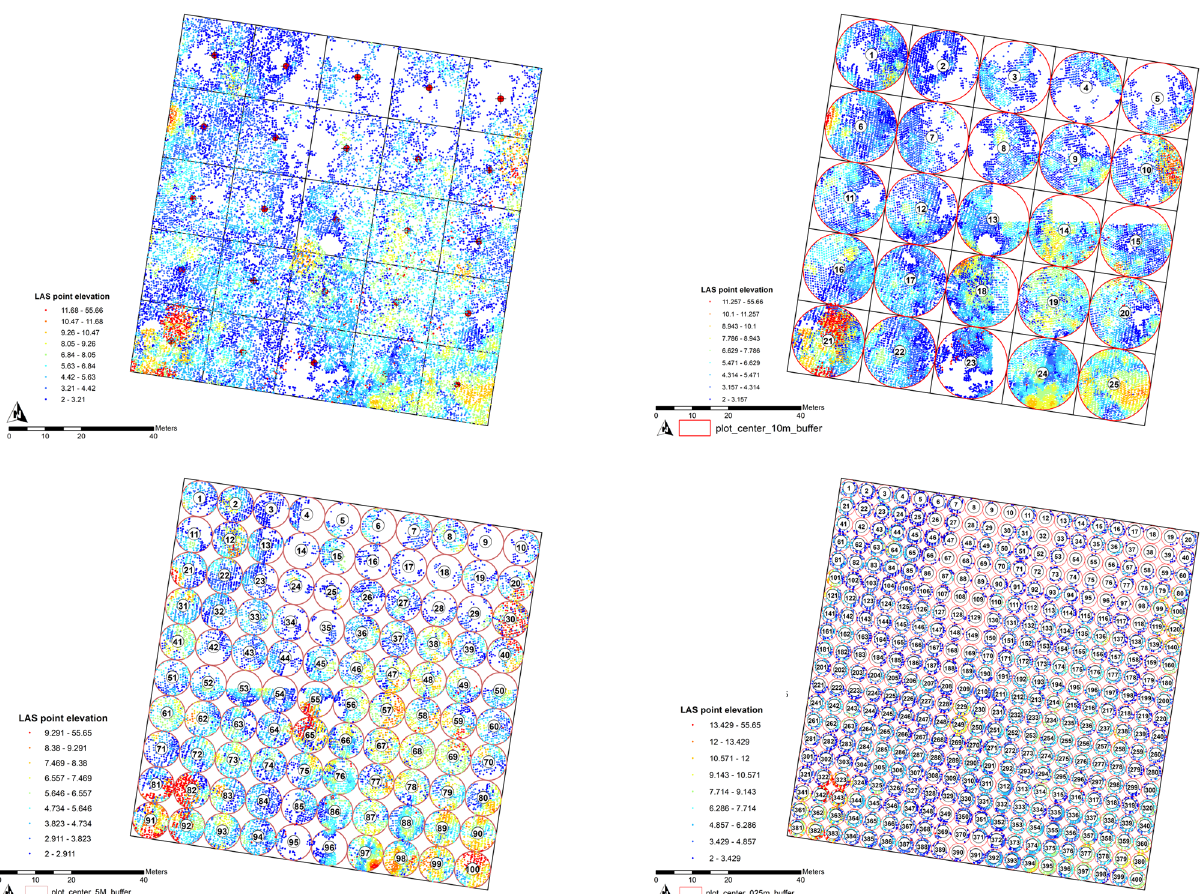
Figure 4. The ( a ) 1 ha rectangular plot clipped into ( b ) twenty-five 10 m radius circular plots; ( c ) one-hundred 5 m radius plots; and ( d ) four-hundred 2.5 m radius plots respectively; for the LiDAR metrics derivation.